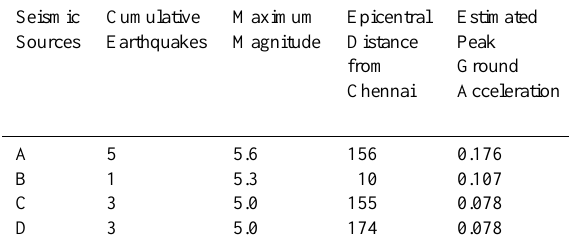
Table 1. Estimated Peak Ground Acceleration (PGA) values Chen- nai city by the closest potential seismic